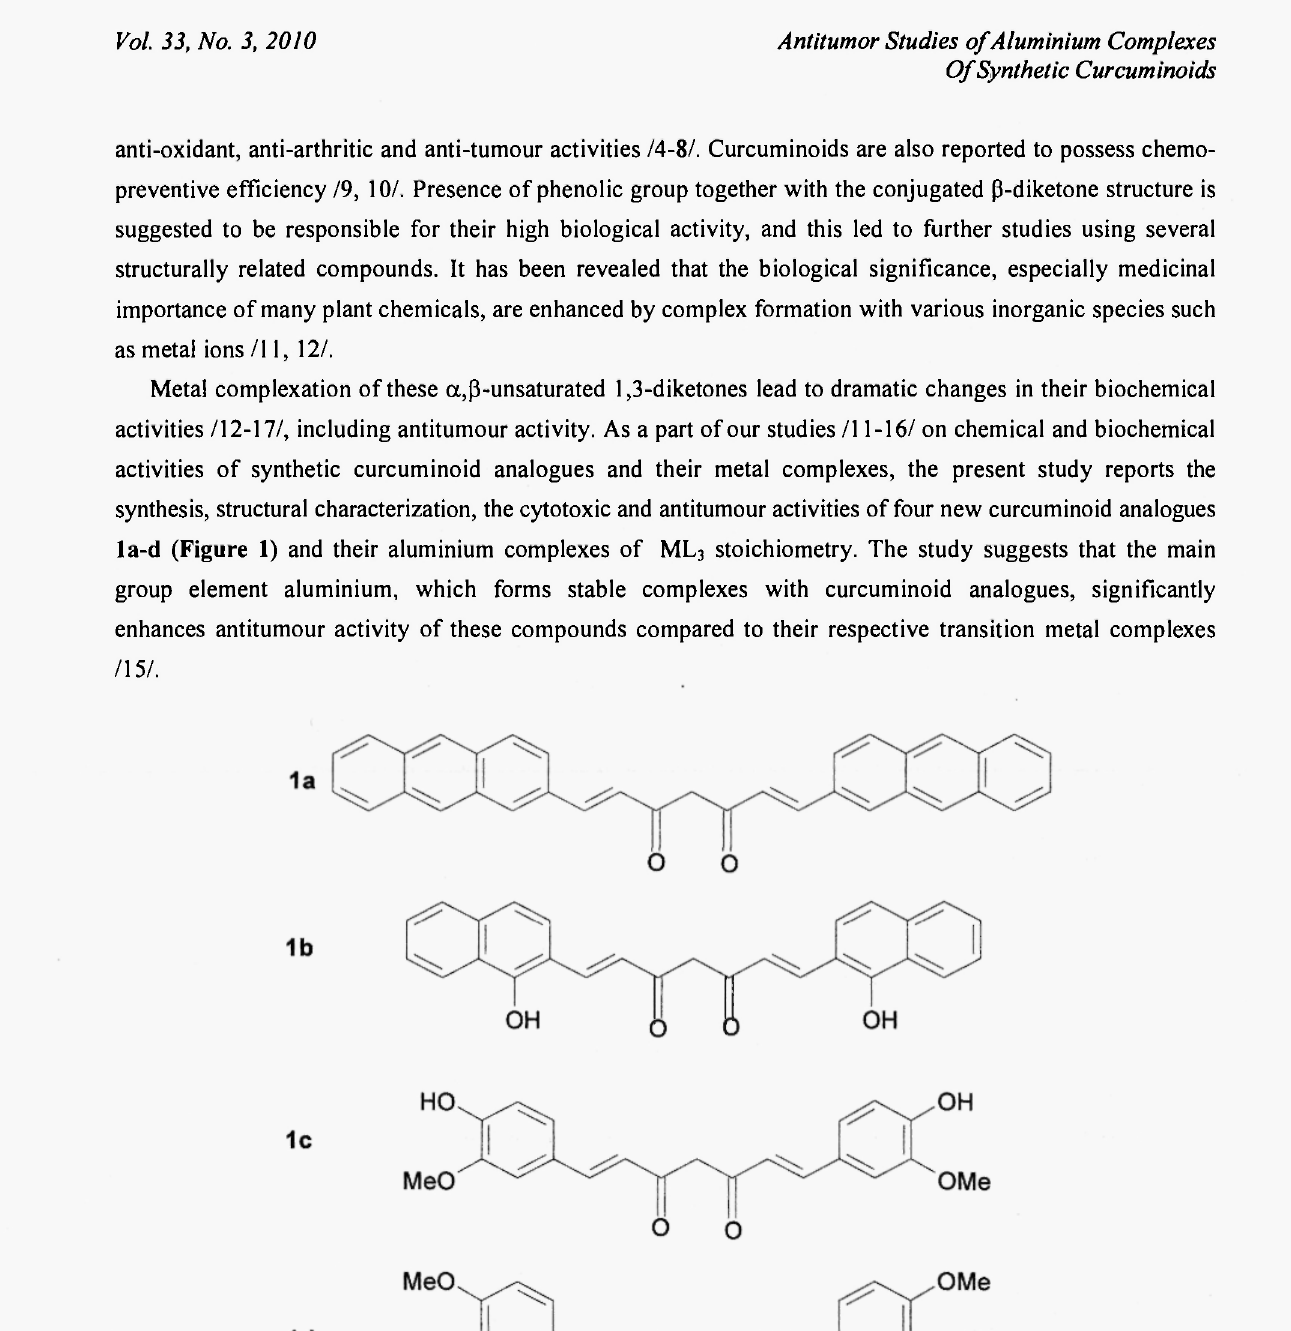
Fig. 1: Structure of curcuminoid analogues a. (HL 1 )